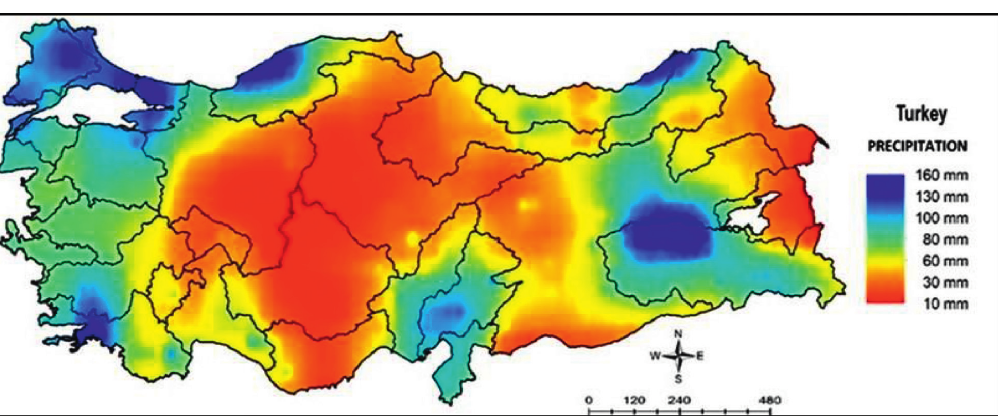
Figure 3: Areal precipitation distribution map for Turkey (December